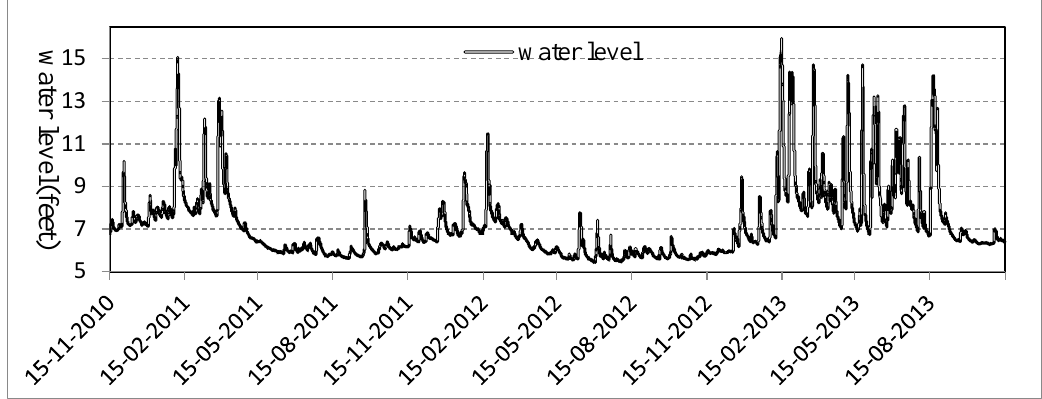
Figure 5. Real-time water level data of Echeconnee Creek.